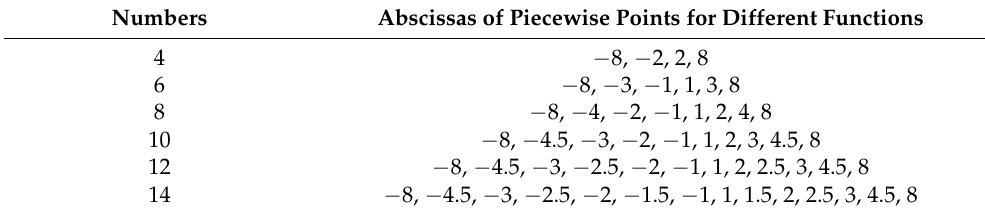
Table 2. Different abscissas with various numbers of piecewise